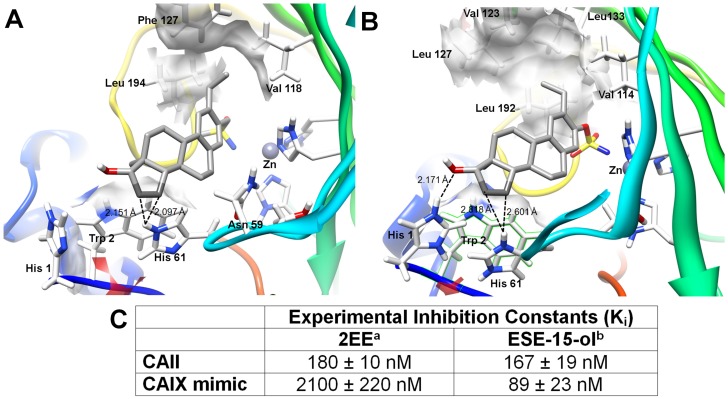
Docking and kinetics data of ESE-15-ol.Docking of compound 10 into a mimic of CAIX (A) and the wild-type isoform of CAIX (B) revealed that the double bond of ESE-15-ol at C15 and C16 may act as a nucleophile and interact with the electrophilic hydrogen of His 61. This interaction is posited to be specific of ESE-15-ol over 2EE and explain the isoform specificity of ESE-15-ol towards the CAIX mimic over CAII. Kinetics data (C) demonstrates that ESE-15-ol has an almost 2-fold higher affinity for the CAIX mimic when compared to the wild-type CAII. a Experimental inhibition constants were determined by Sippel et al. (2011) [35]. b The inhibition of the catalyzed exchange of 18O between CO2 and water as measured by membrane-inlet mass spectrometry was used to determine the experimental inhibition constants (Ki) of ESE-15-ol [16]. A CA IX mimic was used as characterized previously by Genis et al. 2009 [15].